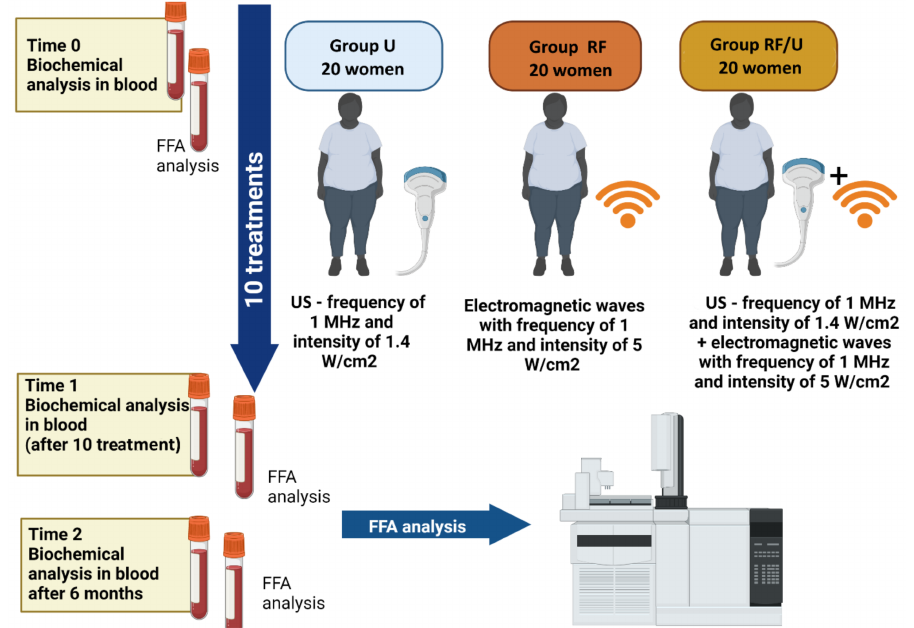
Figure 1. Study design (prepared using BioRender